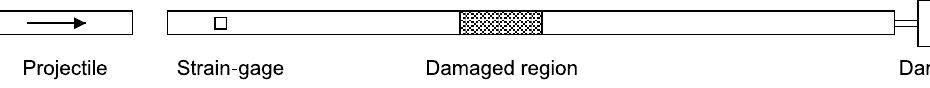
Fig. 2. Depict of an experimental pulse-echo